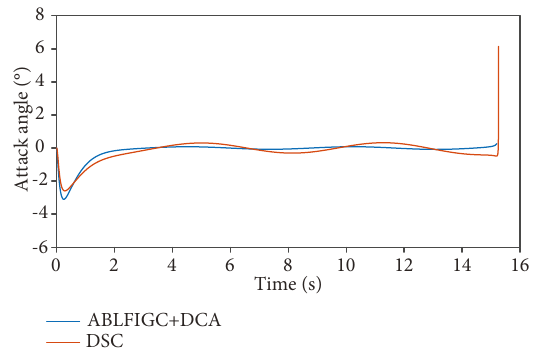
Figure 6: Pitch angular velocity curves of the interceptor missile in Scenario 1: ABLFIGC+DCA refers to a combination of the proposed asymmetric barrier Lyapunov function-based IGC algorithm and the dynamic control allocation algorithm; IGC+DCA refers to a combination of the IGC algorithm subject to the traditional dynamic surface sliding-mode control law and the dynamic control allocation algorithm.